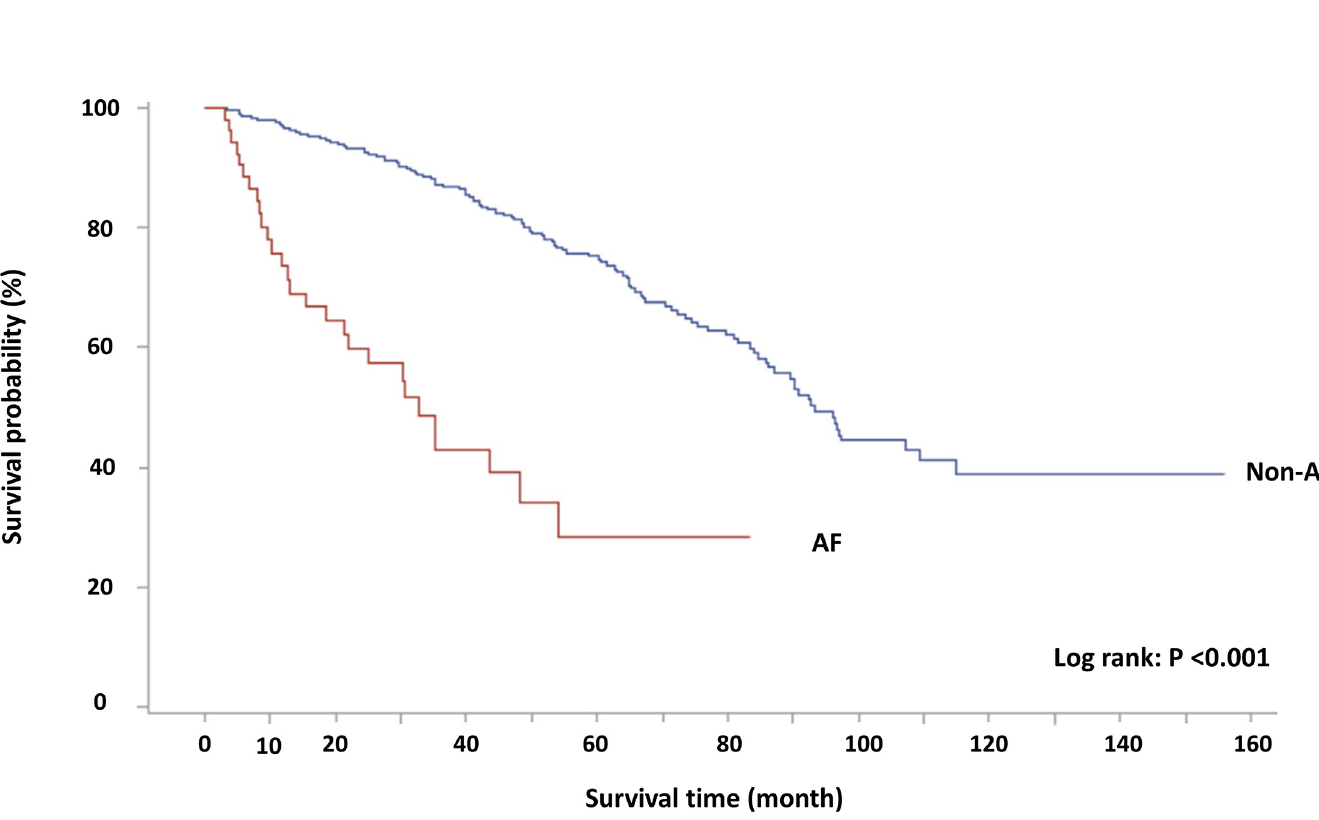
Fig 1. Distribution of AF patients stratified by age tertiles. Statistics was performed using the Cochrane-Armitage test. The number of AF patients were 9 (6.82%), 20 (14.18%), and 28 (23.33%) in the age tertiles of age � 61, 61 < age � 77, and 77 < age, respectively. AF, atrial fibrillation.